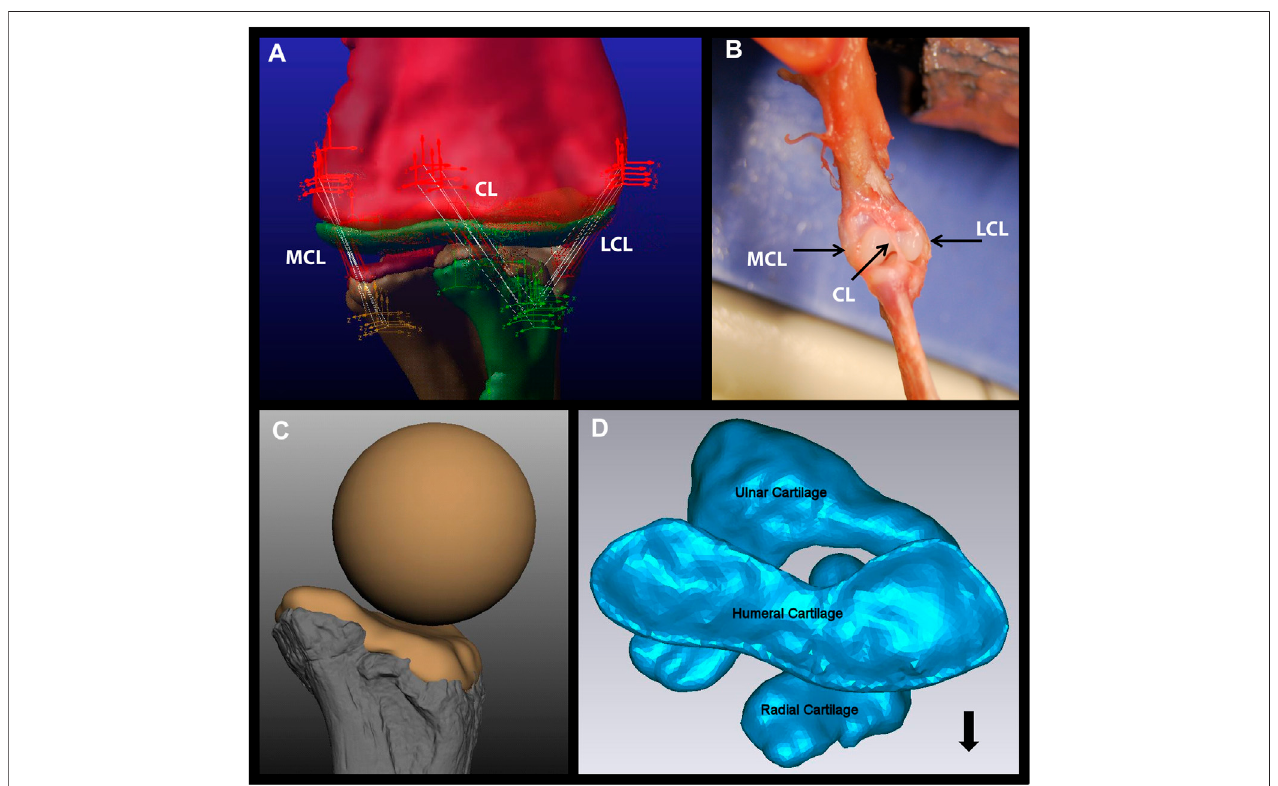
FIGURE 1 | Components of the Dreadnoughtus model. (A) The fi ve strands of each of the three ligaments modeled in the elbow of Dreadnoughtus schrani . The orthogonal, tripartite icons mark the locations of attachment of each ligament strand, which are shown as white lines. The red icons mark attachment locations on the humerus,theyellowiconsmarkattachmentlocationsontheulna,andthegreeniconsmarkattachmentlocationsontheradius.Allobjects(bones,articularcartilage)are shown as semi-transparent to allow all ligament strands to be visible. (B) Dissection of a juvenile alligator left forelimb with black arrows pointing to the three ligaments identi fi ed. (C) The proximal end of the radius of Dreadnoughtus in anterior view with a 2% thick articular cartilage shape, along with the sphere (of diameter matching the curvature of the proximal end of the radius) used to create the anterior spherical articular cartilage on the humerus for our three ensuing biomechanical models. Bone is shown in shades of gray, cartilage in tan. (D) The 2% articular cartilages in their equilibrated positions (after the model was simulated to establish equilibrium), shown in proximal view. The humeral cartilage is seen overlaying the radial and ulnar articular cartilages. The radius is located in an anterolateral position, allowing the ulnar articular cartilage to articulate with both distal condyles of the humerus. The black arrow points anteriorly. Abbreviations: CL, central ligament; LCL, lateral collateral ligament; MCL, medial collateral